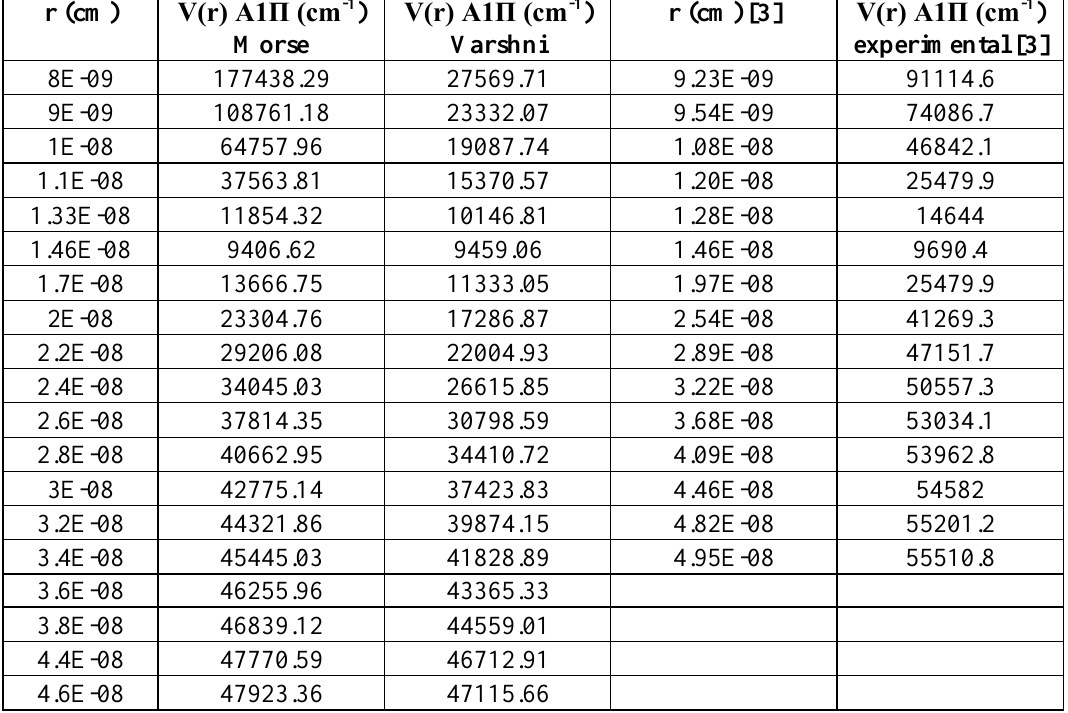
Table 3: Theorttical and experimental Values of potential energy for exited state A 1 Π of BeO molecule